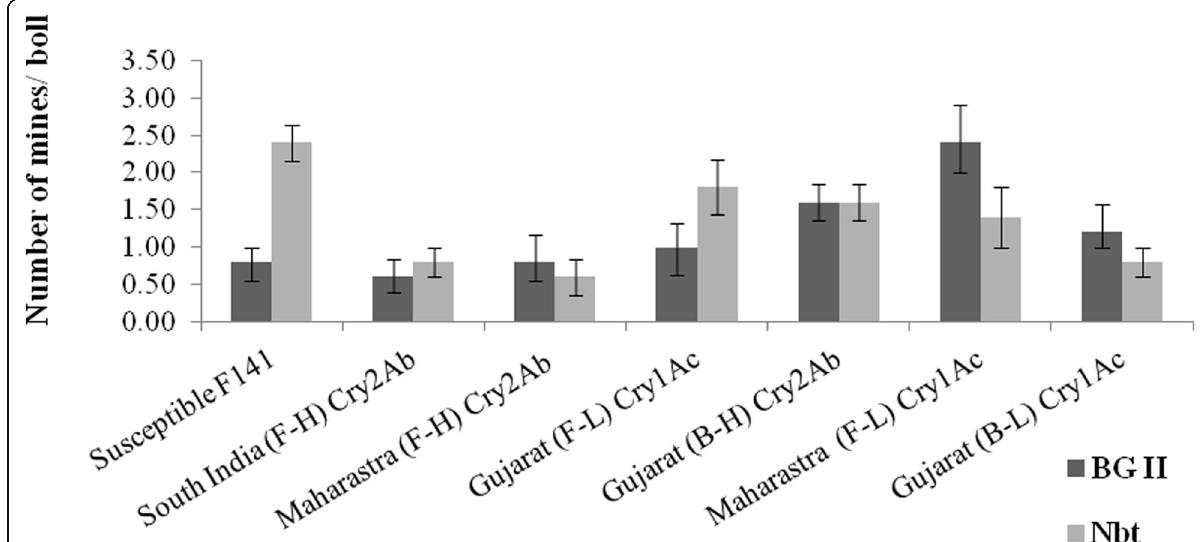
Fig. 1 Number of mines on epicarp damaged by susceptible and resistant strains of Pectinophora gossypiella to Cry toxins. Bar heights represent sample means, and error bars are the standard error of the